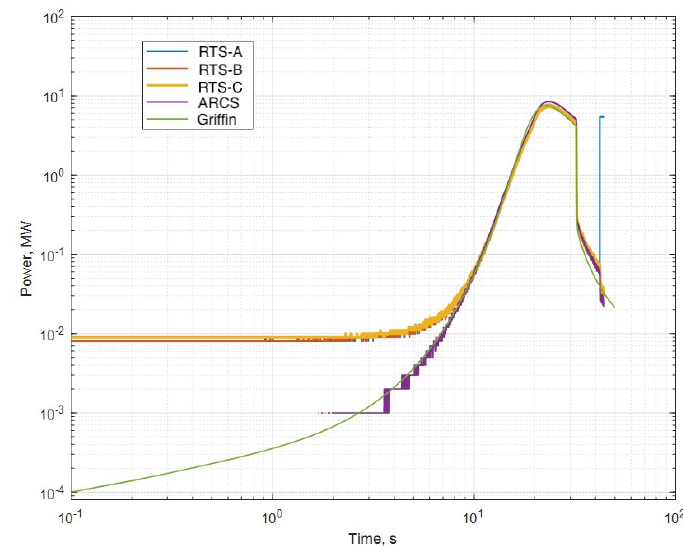
Figure 11. Log-log plot of the simulated and measured core power.